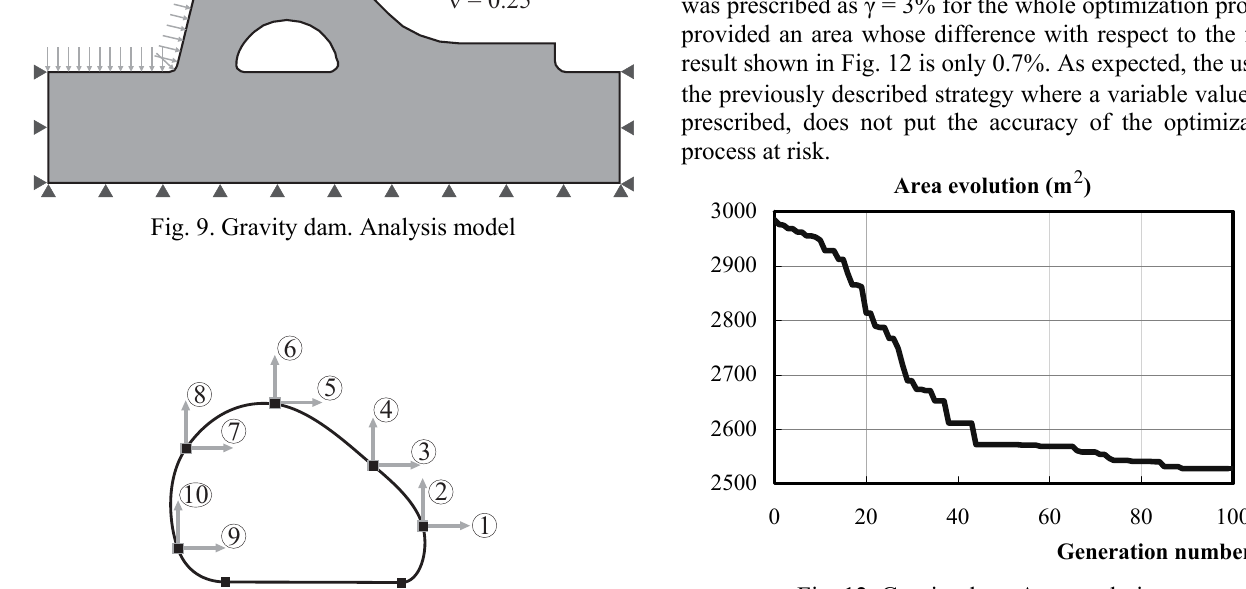
Fig. 12. Gravity dam. Area